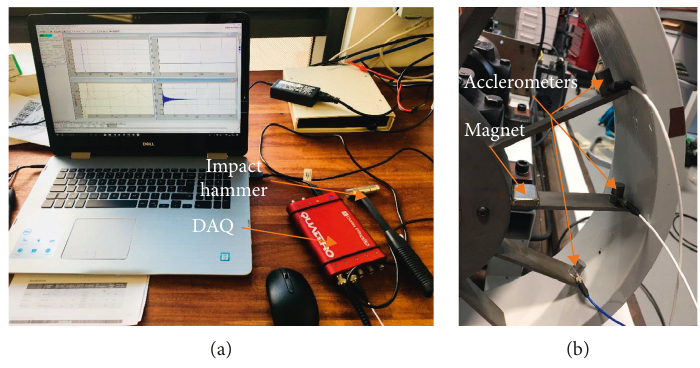
Figure 3: (a) Impact hammer test setup; (b) blade with added magnet